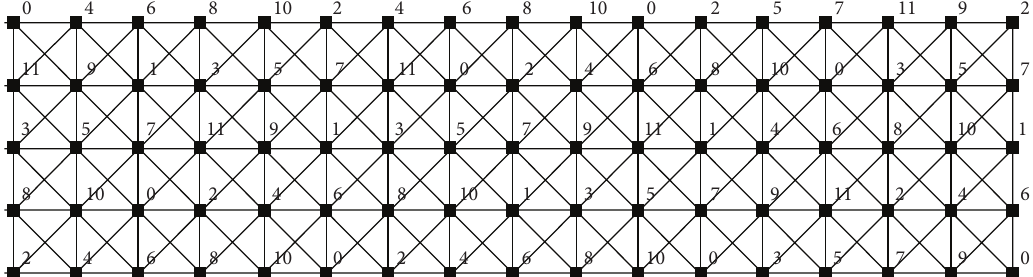
Figure 9: 11 - 𝐿(2,1) -labeling of 𝑃 5 ⊠ 𝐶 17